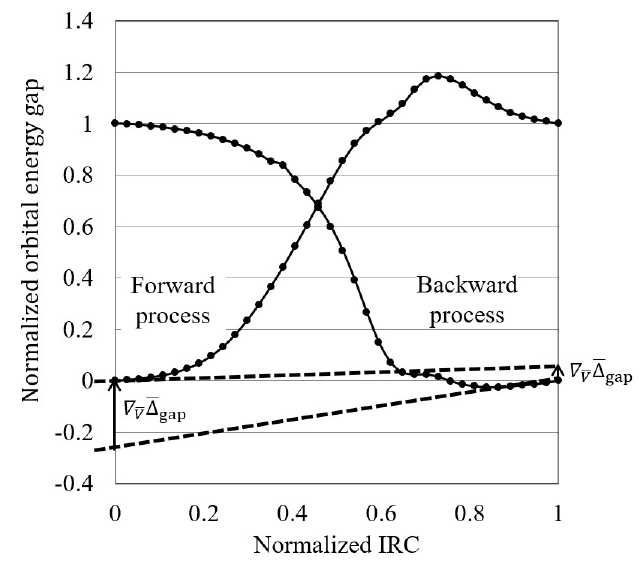
Figure 1. A normalized reaction diagram, in which both the gaps and intrinsic reaction coordinates are normalized by setting the values of the reactant and product to be zero and one, respectively. For both forward and backward reactions, the orbital energy gap gradients are estimated by fit to polynomial